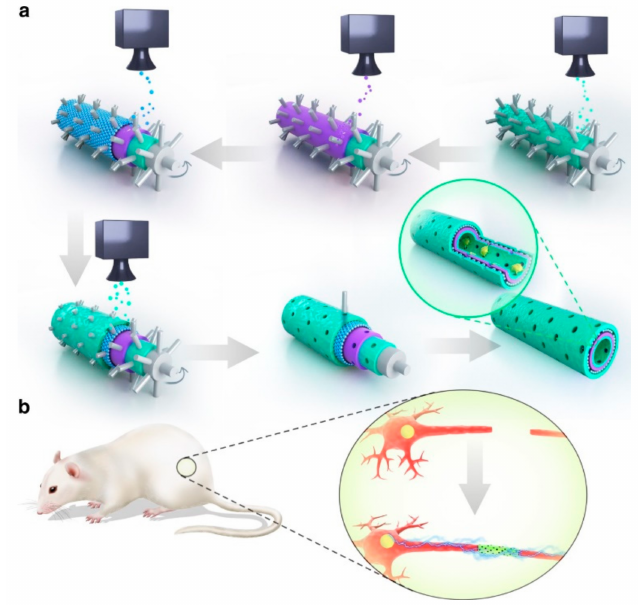
Figure 11. Schematic diagram of graphene neural catheter made by LBLC method: ( a ) The innermost and outermost green layers are the PDA/RGD hybrid layers. The purple layer is a mixed layer of single or multilayer graphene and PCL. The blue layer is a repeat of the graphene and PCL mixed layer. ( b ) Single or multilayer graphene/PCL nerve catheterization in an SD rat model of sciatic nerve defect. Data reproduced with permission from Ref.